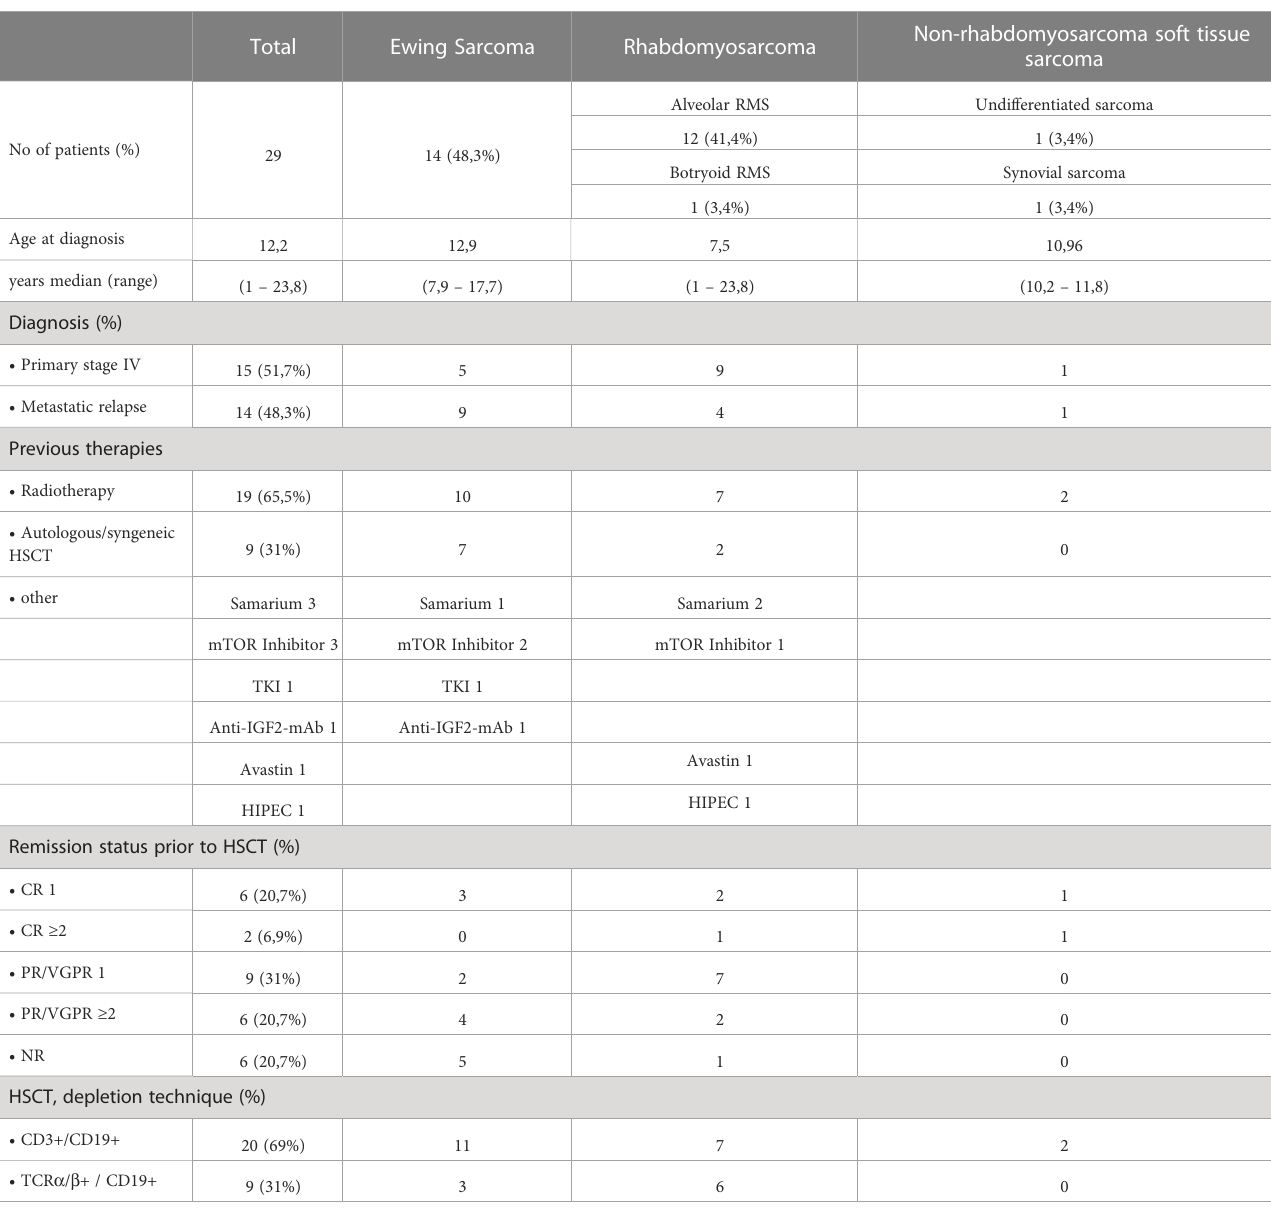
TABLE 1 Patient